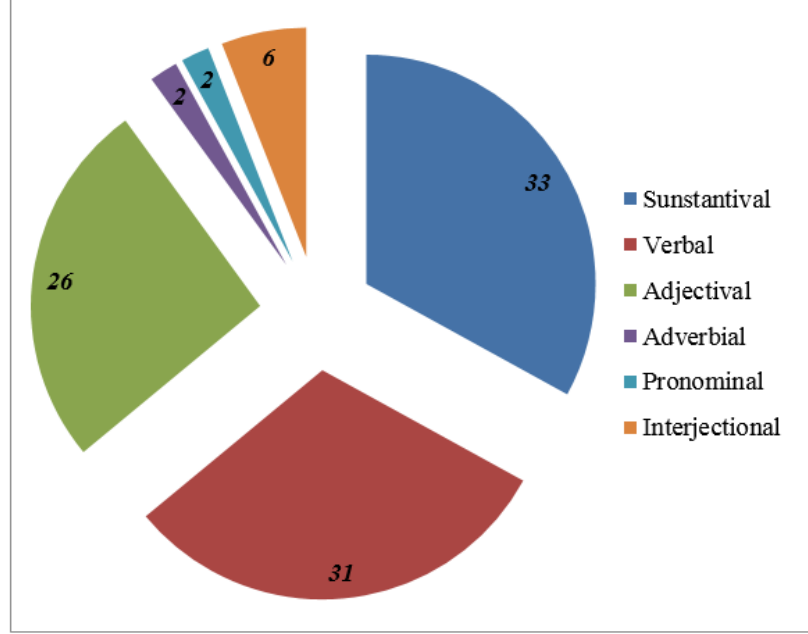
Fig. 1 – Part-of-speech affiliation of the English enantionyms, %